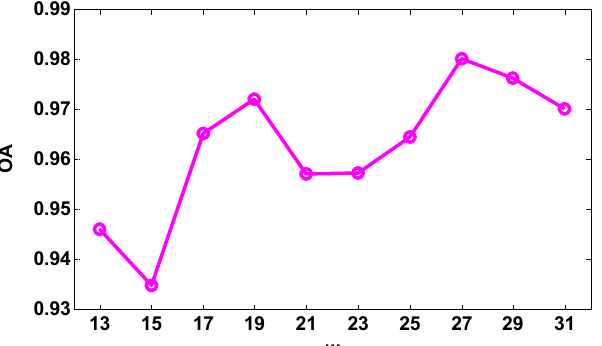
Figure 8. The overall accuracy (OA) values vs different spatial size w of the input data.